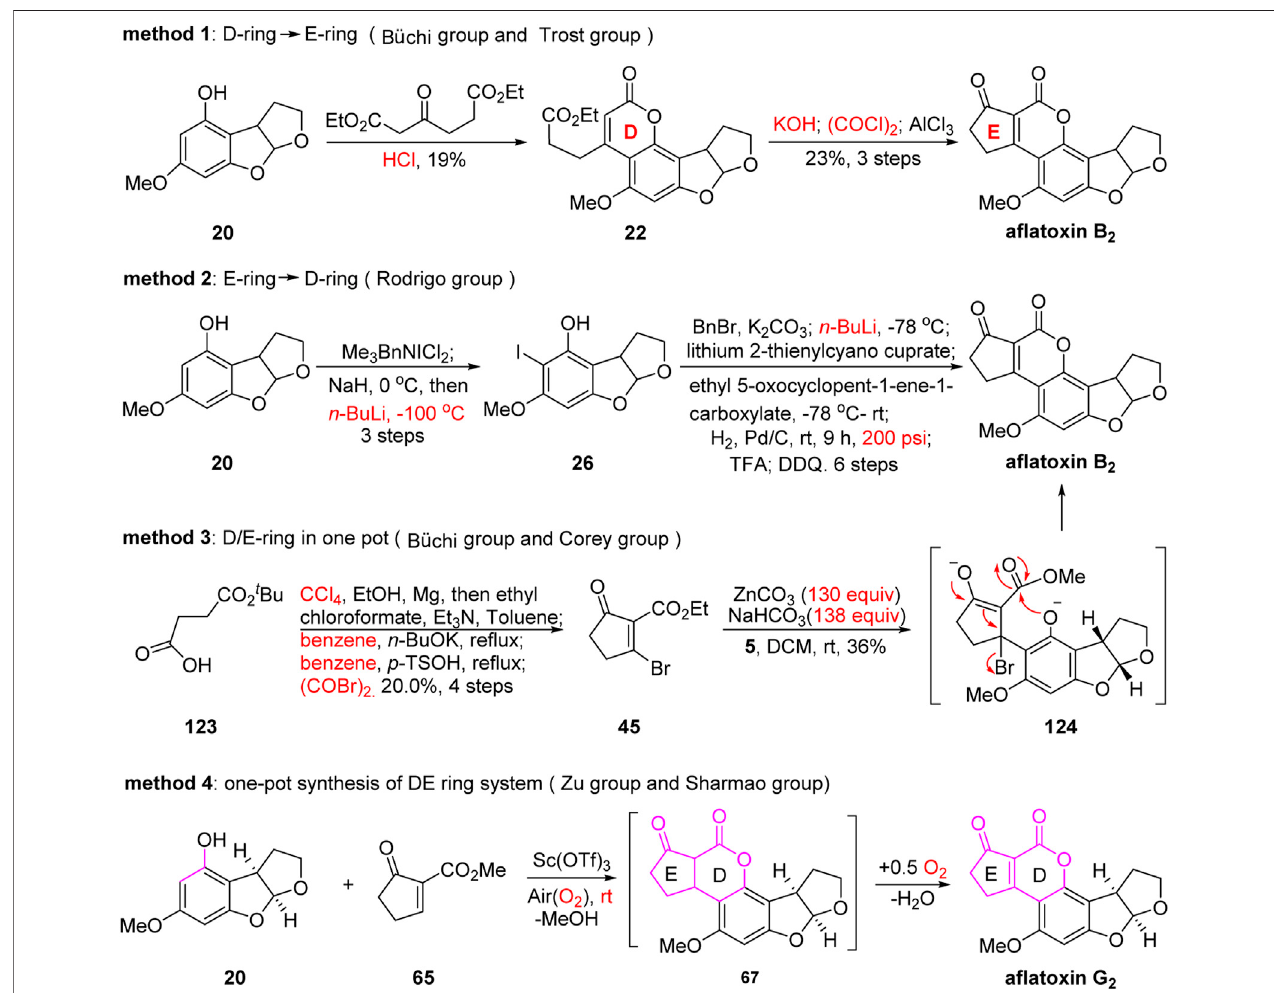
FIGURE 14 | Four types of methods for the preparation of the DE ring system.